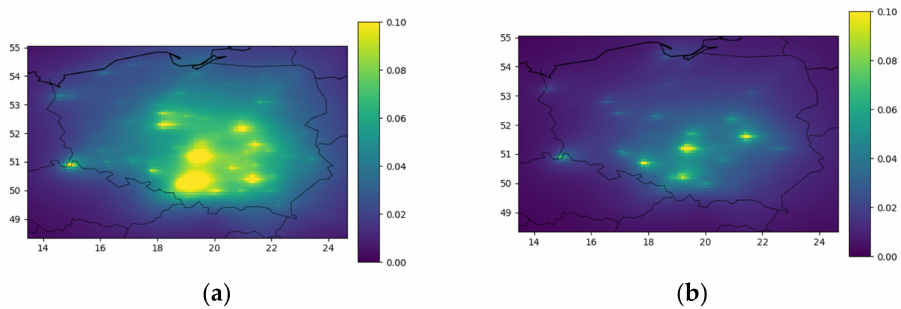
Figure 2. The ambient PM10 concentration at surface level resulting from the emissions of the power